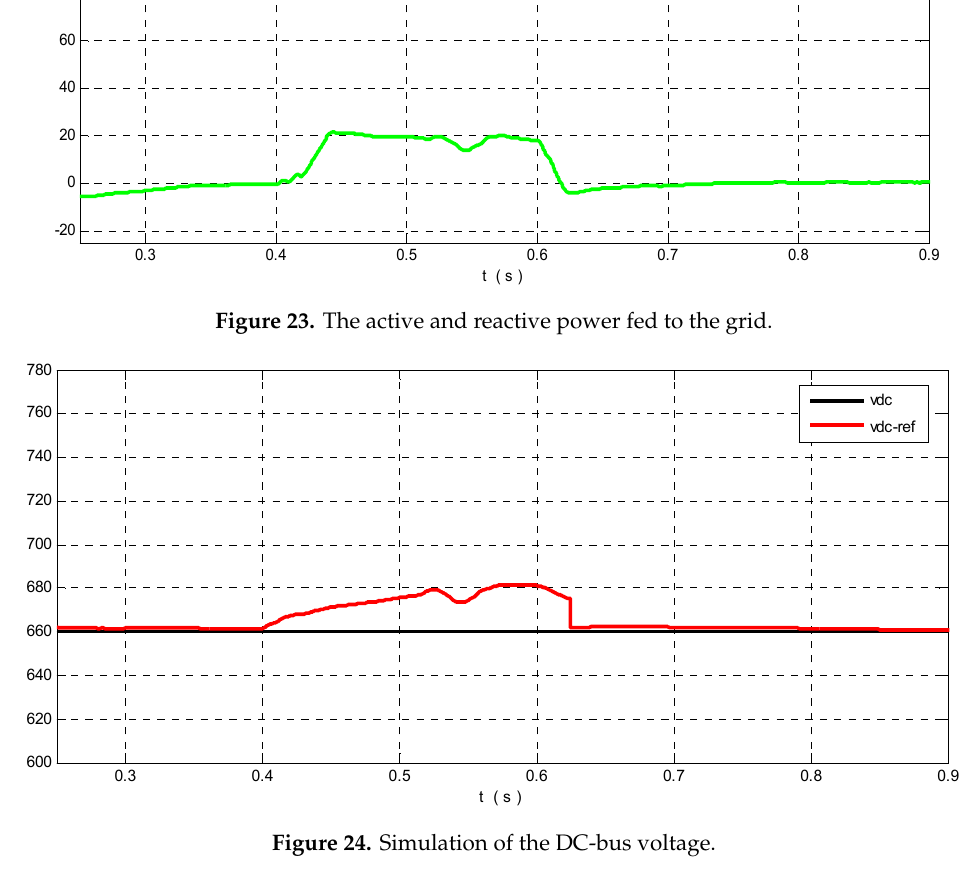
Figure 24. Simulation of the DC-bus voltage.